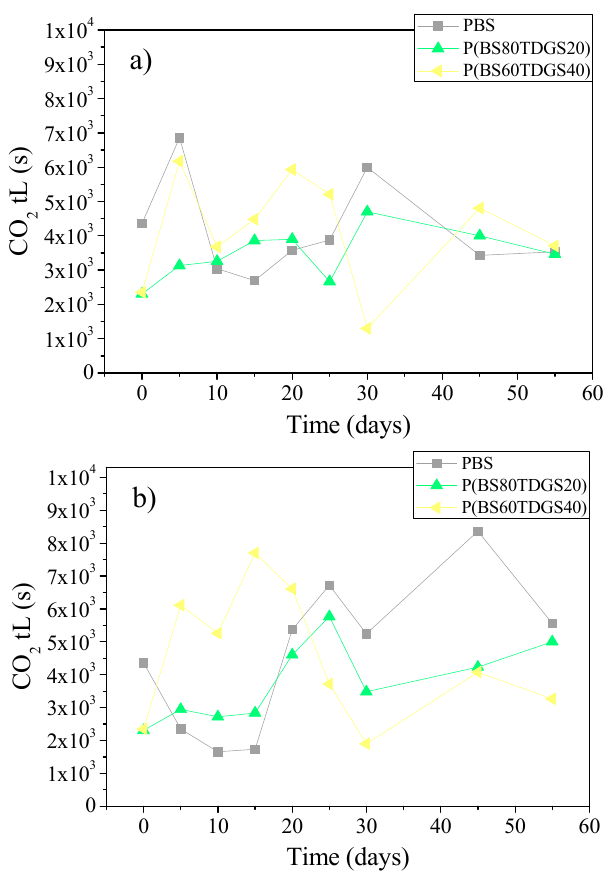
Figure 5. t L coefficients for PBS and P(BSxTDGSy) copolymers after: ( a ) thermal ageing (at 40 °C, 50% RH, air ventilated); ( b ) photo-ageing at 23 °C, D65 Neon light, 50% RH, air ventilated.